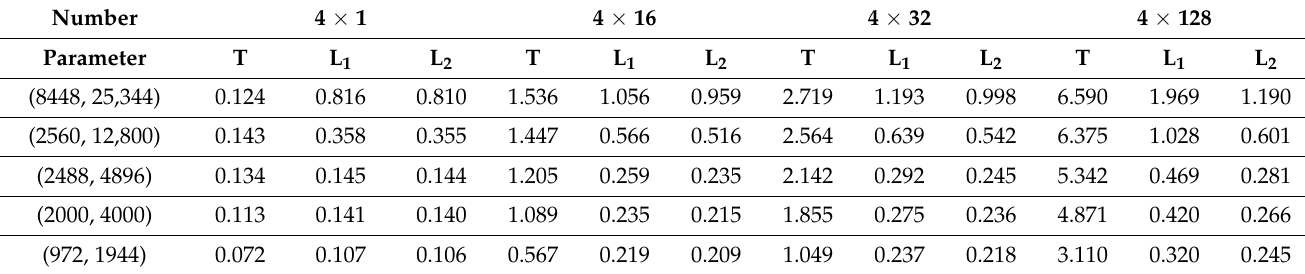
Table 1. The throughput and latency parameters of the LDPC decoder for different rates and